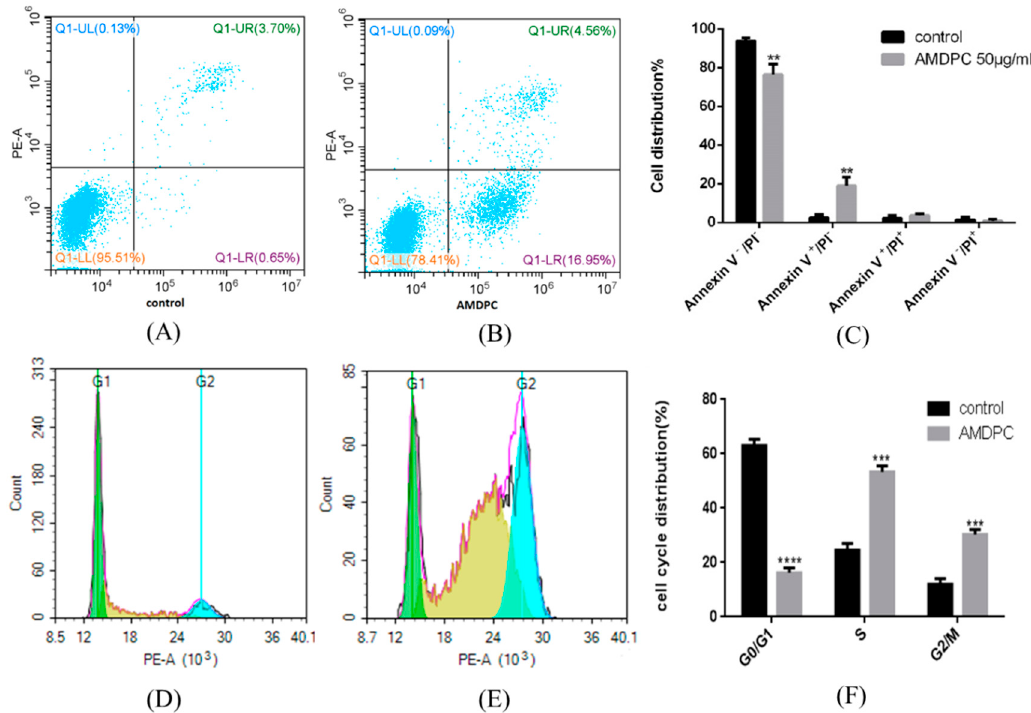
Figure 6. Flow cytometry analysis of cell apoptosis, P21 protein expression, and cell cycle arrest induced by mPEG-PLGA/AMDPC on BCAP-37 cells. Cells were treated with 50 µ g/mL of AMDPC for 36 h. ( A ) Control group with no treatments. ( B ) AMDPC-induced BCAP-37 cell apoptosis. ( C ) Cell apoptosis analysis of AMDPC-treated cells. Annexin V and PI were used to stain phosphatidylserine (PS) and nuclei respectively then distinguished the cells from early apoptosis to necrosis by flow cytometry. ( D ) Cell cycle analysis for control group with no treatments. ( E ) AMDPC-induced BCAP-37 cells cycle arrest. Cells were treated with concentration of AMDPC 50 µ g/mL for 36 h. Propidium iodide staining was used to determine the DNA content. ( F ) The percentage analysis of BCAP-37 cells in different phases of cell cycle was calculated by flow cytometry. Data represent the mean ± SD ( n = 3), ** p < 0.01, *** p < 0.001, **** p < 0.0001 versus control group.